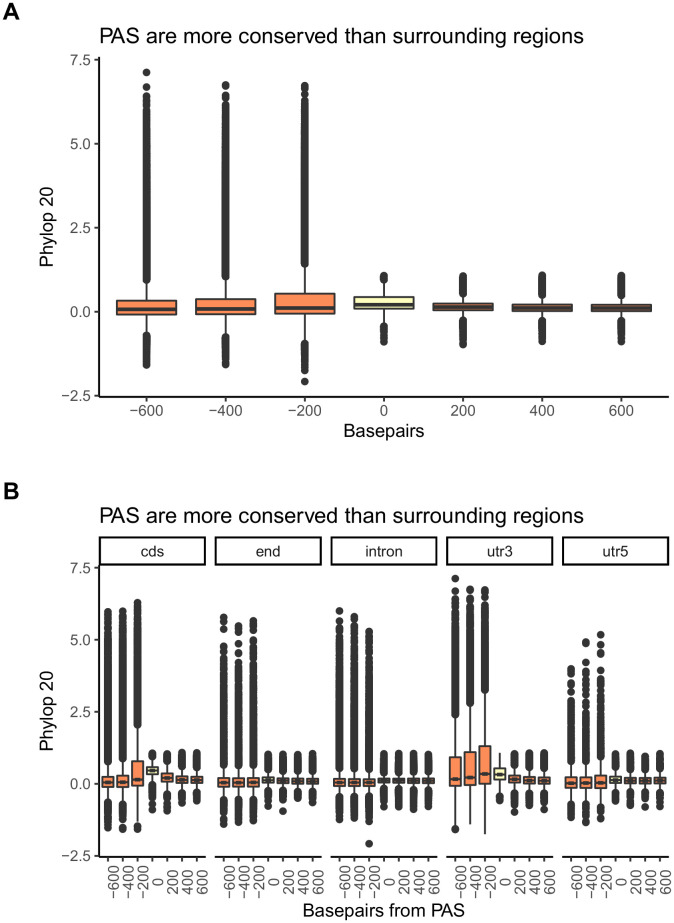
Polyadenylation sites (PAS) regions are conserved in the mammalian lineage.Mean PhyloP scores for PAS regions (yellow) and 200 base pair bins upstream and downstream of PAS (orange) (A) Figure 1B recapitulated with PhyloP scores calculated over 20 vertebrate species. (B) Figure 1—figure supplement 8 recapitulated with PhyloP scores calculated over 20 vertebrate species. One-sided Wilcoxon test was used to test for increased PhyloP in PAS regions (cds-coding region: p<2.2×10−16; end-5 kb downstream of genes: p<2.2×10−16; intron: p<2.2×10−16; utr3-3' UTR: p<2.2×10−16; utr5-5' UTR: p<2.2×10−16).